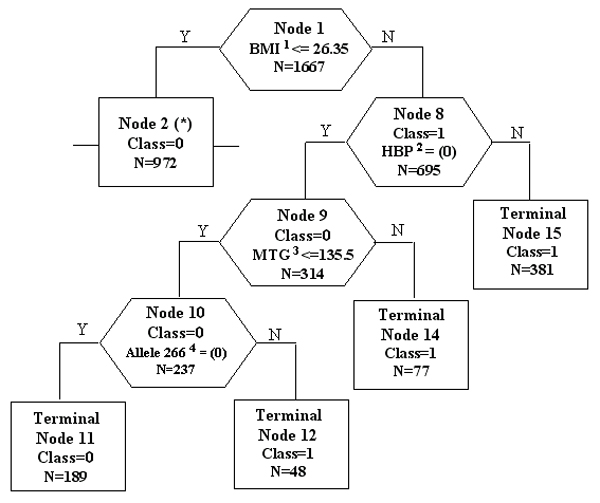
A proportion of an optimal tree from classification tree Decision node criteria: 1. BMI: average BMI across-section 2. HBP: ever hypertension in all sections 3. MTG: average maternal triglycerides 4. Allele 266 of D16S2620 Definition of classes: Class 0, glucose levels < 110 mg/dl in all section; Class 1, at least one observed fasting glucose levels >110 mg/dl.